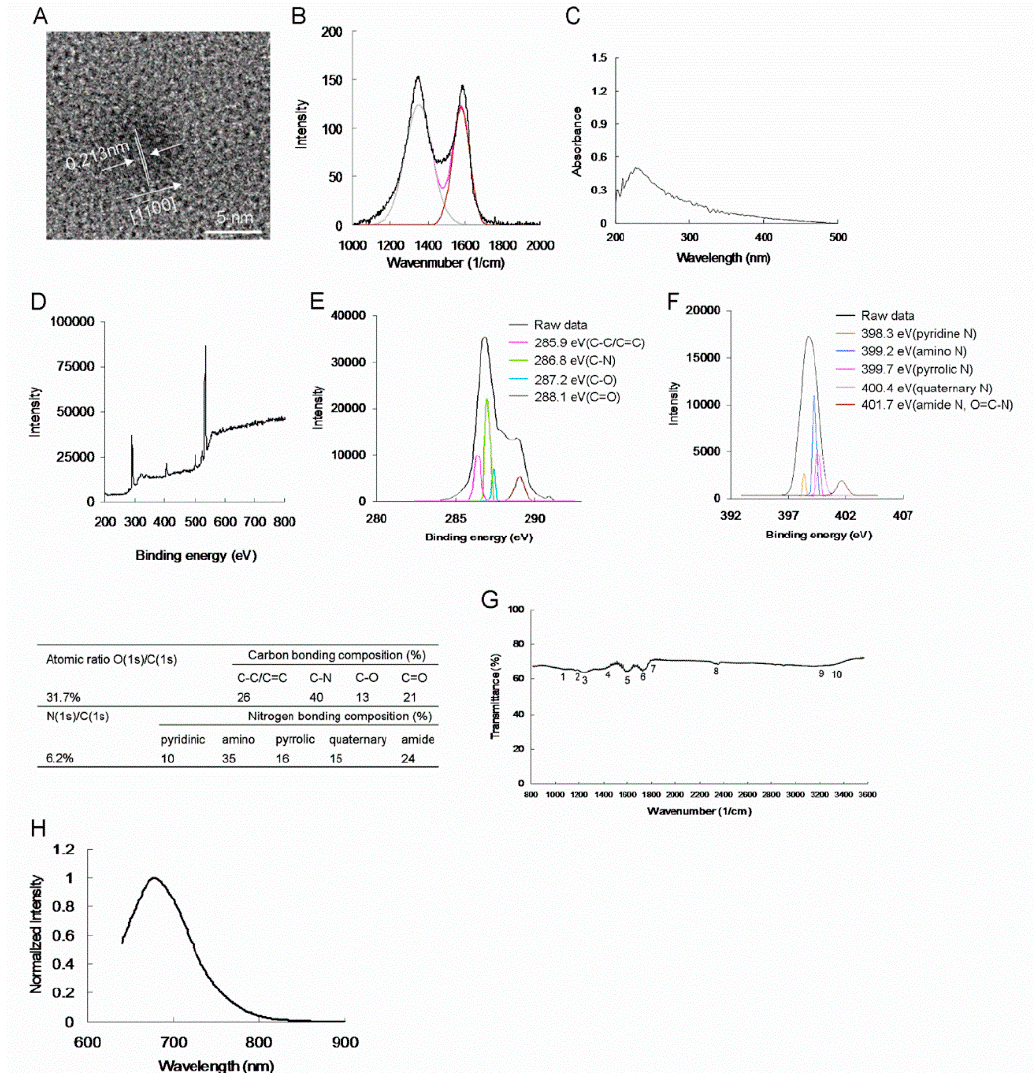
Figure 1. ( A ) HR-TEM image obtained for a single amino-N-GQD (6.2%) that exhibited a 0.213-nm d -spacing. ( B ) Raman spectroscopy results indicating the material’s crystallinity. The gray and brown lines indicate that the spectrum was decomposed and fitted into the D-band (~1383 cm − 1 ) and G-band (~1605 cm − 1 ) peaks (black line: raw data; pink line: decomposed spectrum). ( C ) UV–Vis spectrum of the material. ( D ) Full-range XPS results for the material. ( E , F ) Peaks fitted by employing a Gaussian function for the deconvoluted C(1s) and N(1s) XPS spectra. The peaks of a nonoxygenated ring (C–C / C = C) as well as those of the C-N, hydroxyl (C–O), and carbonyl (C = O) bonds were fitted by employing a Gaussian function for the deconvoluted C(1s) XPS spectra. The peaks of pyridinic N (398.2 eV), amino N (NH2), pyrrolic N, quaternary N, and amide N (O = C–N) were fitted by employing a Gaussian function for the deconvoluted N(1s) XPS spectra. The atomic ratios and binding compositions of the amino-N-GQD (6.2%) are summarized in the table. The O(1s) / C(1s) and N(1s) / C(1s) atomic ratios were 31.7% and 6.2%, respectively. ( G ) FTIR spectrum of the material. ( H ) Fluorescence spectrum of amino-N-GQD (6.2%) (Ex / Em: 630 nm / 683